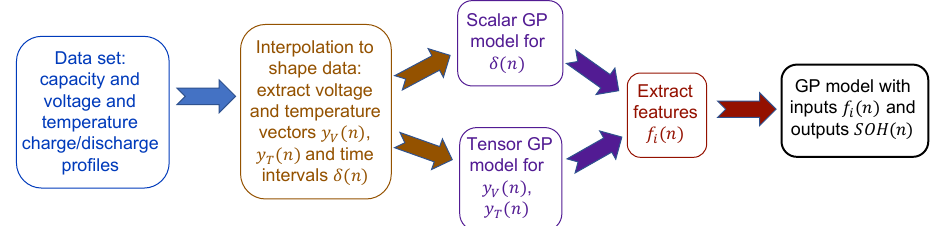
Figure 7. Schematic of the model for estimating the SOH using predicted features obtained from predicted voltage and temperature curves.